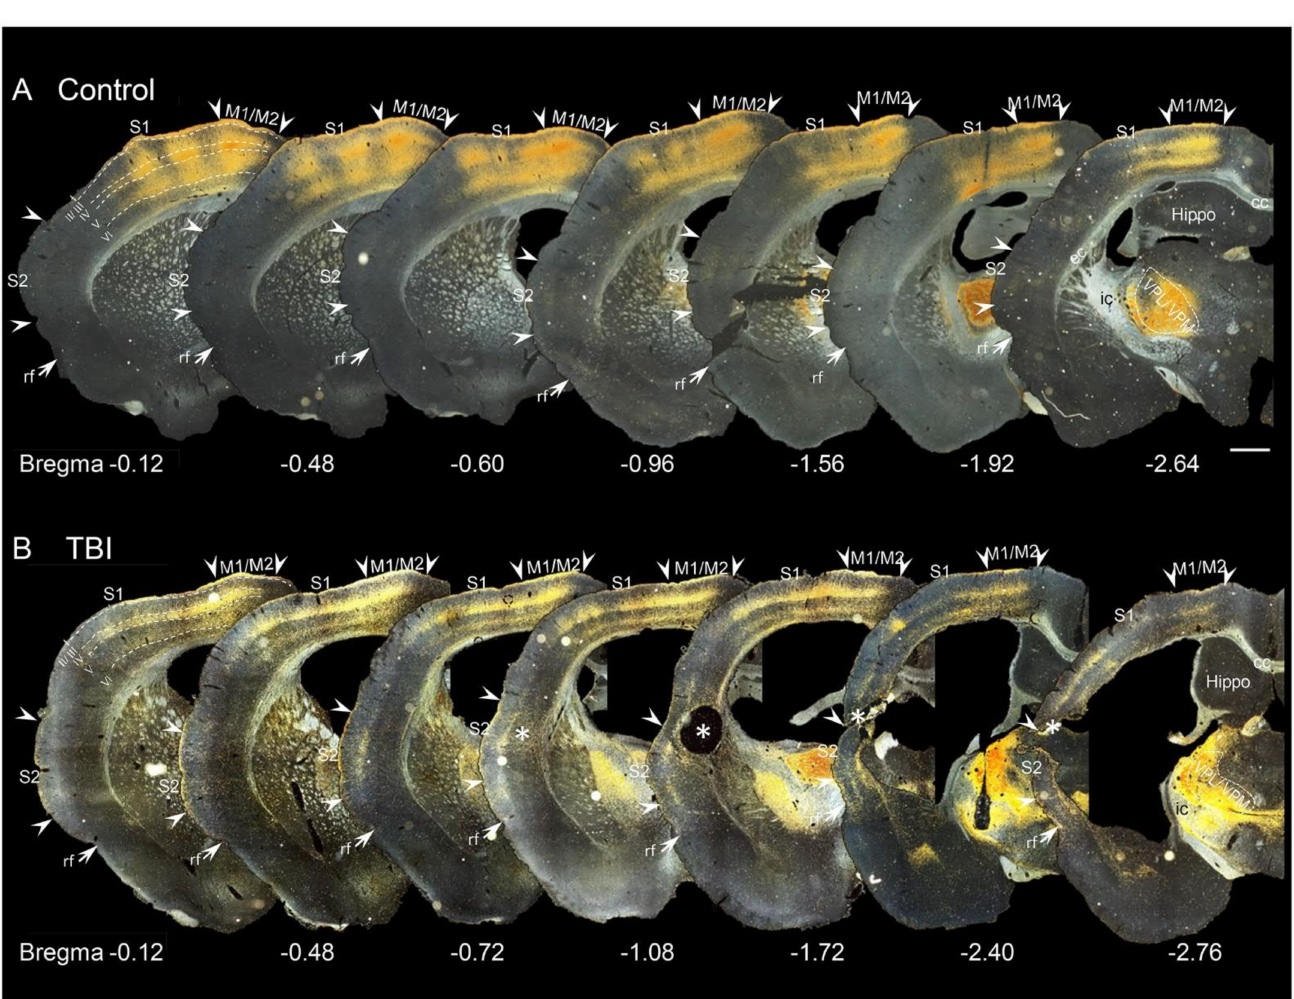
Figure 3. Coronal darkfield photomicrographs demonstrating the anteroposterior distribution of GFP-labeled ChR2-eYFP- expressing axonal terminals in the cortex of a control and traumatic brain injury (TBI) rat. ( A ) ChR2-eYFP expression in the cortex of a control rat. The expression ChR2-eYFP in the cortex extended anteriorly with intense expression noticeable in the primary (M1) and secondary (M2) motor cortices as well as in the primary somatosensory cortex (S1). Few ChR2- eYFP-expressing fibers are observed in the secondary somatosensory cortex (S2). ( B ) ChR2-eYFP expression in the cortex of a TBI rat. The pattern of ChR2-eYFP expression is similar to that in the control in panel A. Note the decrease in fiber density and the absence of columnar fiber bundles compared with that in a control rat (panel A). ChR2-eYFP-expressing varicose fibers were also observed around the lesion core (asterisk). Scale bar equals 1 mm. Abbreviations: Hippo, hip- pocampus; ic, internal capsule; rf, rhinal fissure; VPL, ventral posterolateral thalamic nucleus; VPM, ventral posteromedial thalamic